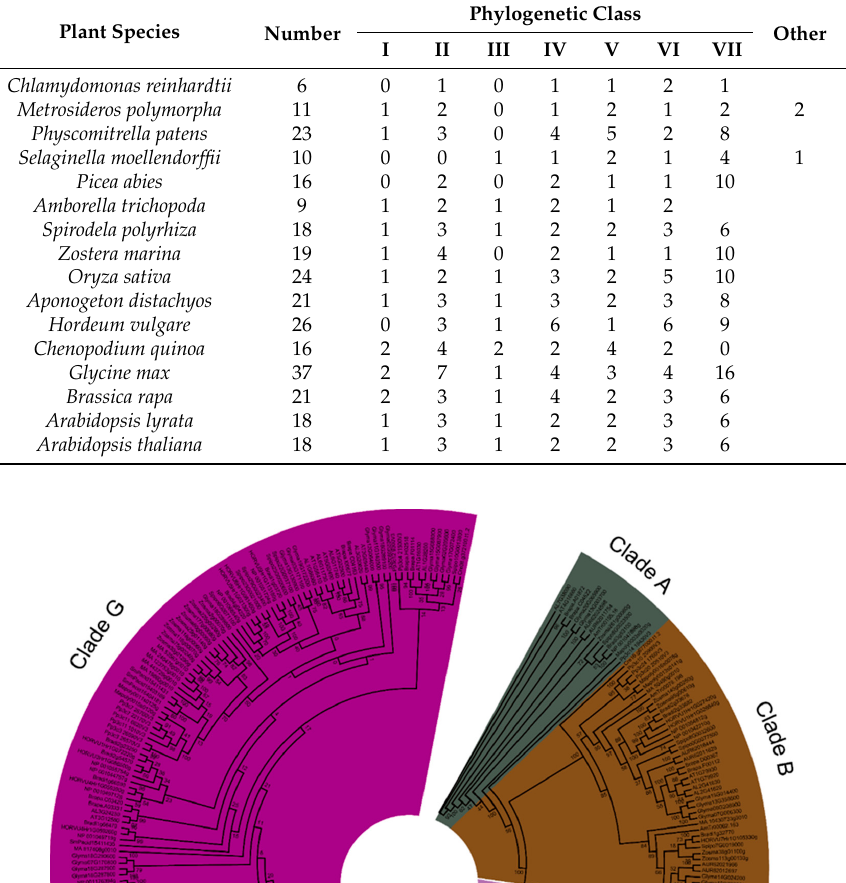
Table 1. Heat-shock proteins 70 (HSP70) family members in selected plant species.